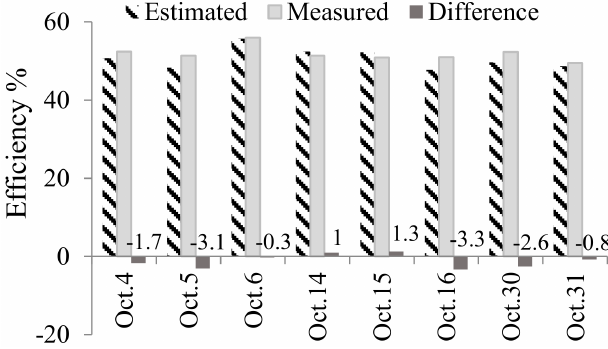
Figure 7. Predicted vs. experimental daily thermal efficiency during October 2015.